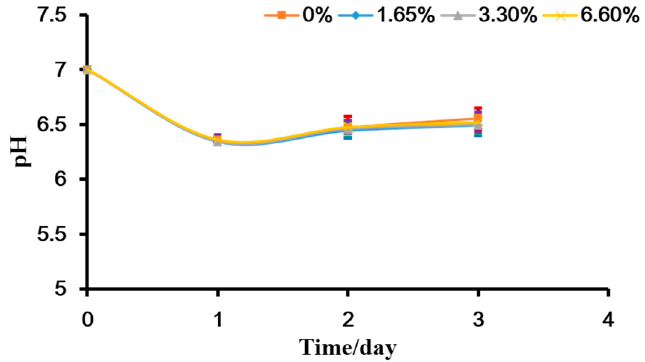
Figure A2. The 2 mL supernatant pH during biofilms formation (There were no significant difference in all groups).